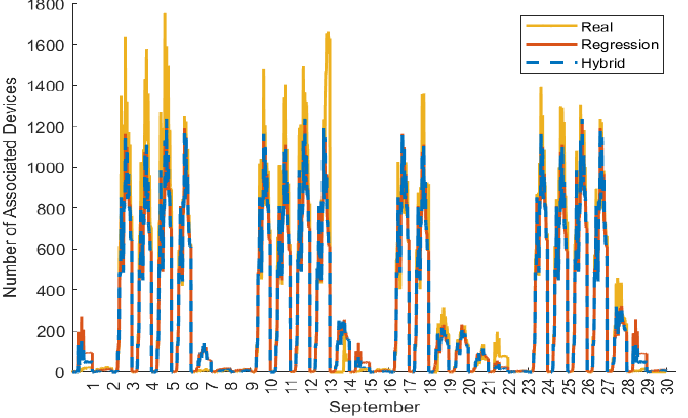
Figure 2. Hybrid model results compared with the real demand and the demand given by the regression results for the whole month of